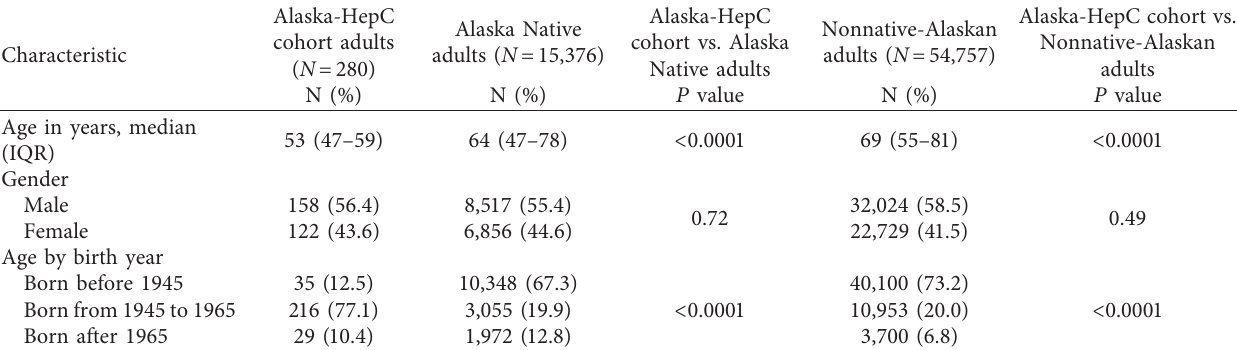
Table 1: Demographics of deaths among the Alaska-hepatitis C cohort, and Alaska Native and Nonnative people in Alaska, 1995–2016. †